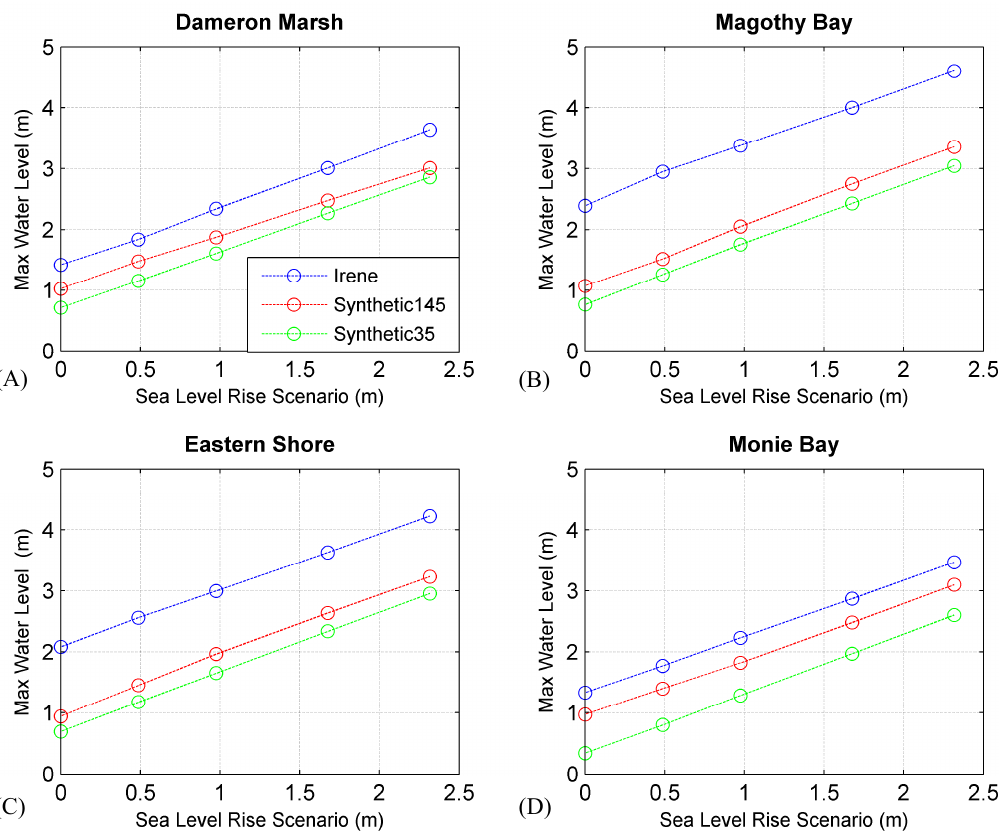
Figure 5. Maximum water levels at each preserve areas for current condition and different SLR scenarios. The top panel shows the simulated maximum water level in ( A ) Dameron Marsh and ( B ) Magothy Bay. In the bottom panel results are shown for ( C ) Eastern Shore and ( D ) Monie Bay Preserve Area.